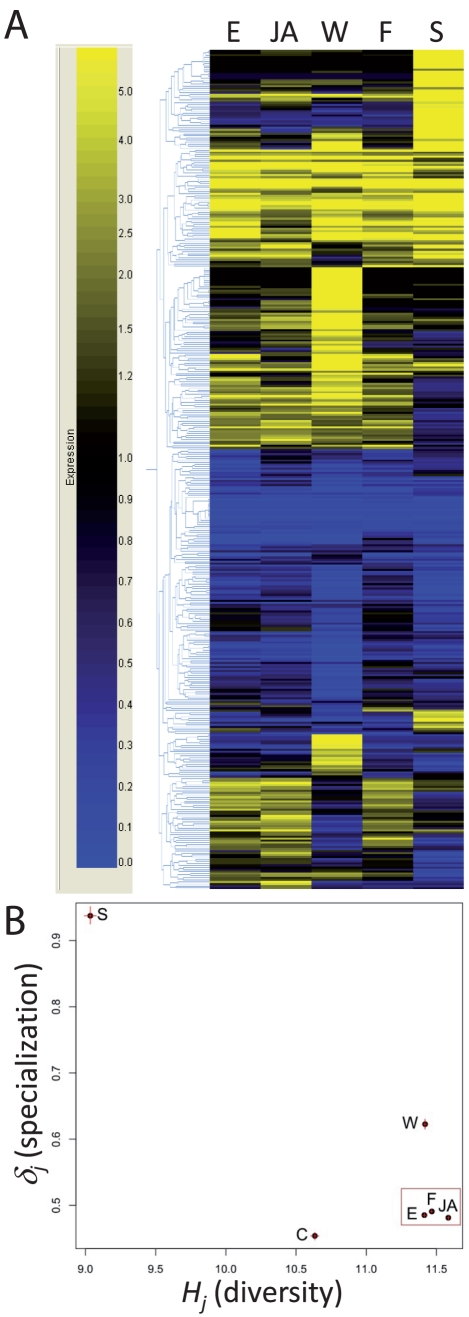
Transcriptomic response of lima bean leaves to damaged-self signals and jasmonic acid (JA).(A) Transcriptomic patterns (genes up- and downregulated in comparison to untreated controls) are presented for JA treatment (JA) in comparison to flame wounding (F), mechanical wounding (W), and mechanical wounding with subsequent application of leaf extract (E) or 1 mM solution of sucrose (S). (B) Scatter plot of Hj (diversity) versus δj (specialization) for each treatment tested.